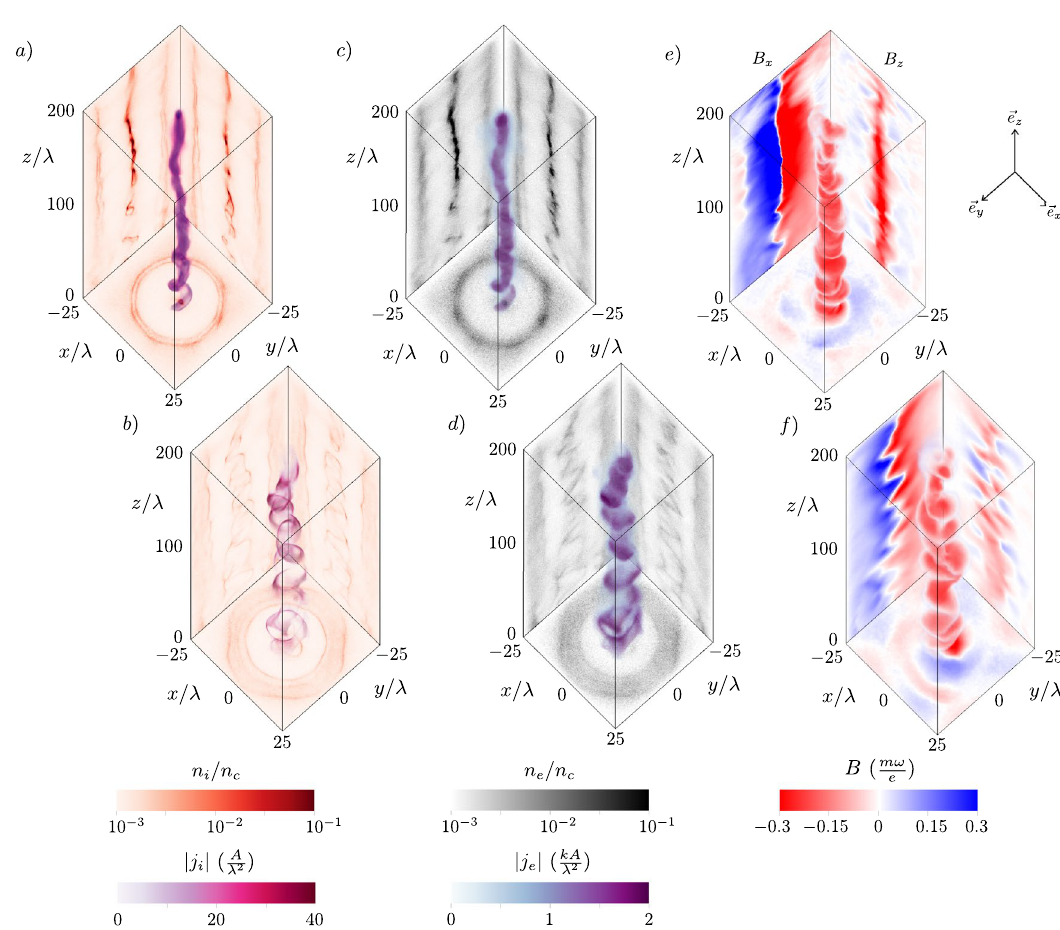
Figure 2. Evolution of quasistatic magnetic fields and plasma currents generated by ultrarelativistic laser. Ion j i current density magnitude (volumetric) and normalized ion density n i / n c (central planes) at simulation time | | 360 T ( a ) and 600 T ( b ). Electron current density magnitude j e (volumetric) with normalized electron density | | n e / n c (central planes) at simulation time 360 T ( c ) and 600 T ( d ). Axial magnetic field B z (volumetric, x-y and x-z central planes) and transverse magnetic field component B x (y-z central plane), which corresponds to the azimuthal magnetic field B φ , at simulation time 360 T ( e ) and 600 T ( f